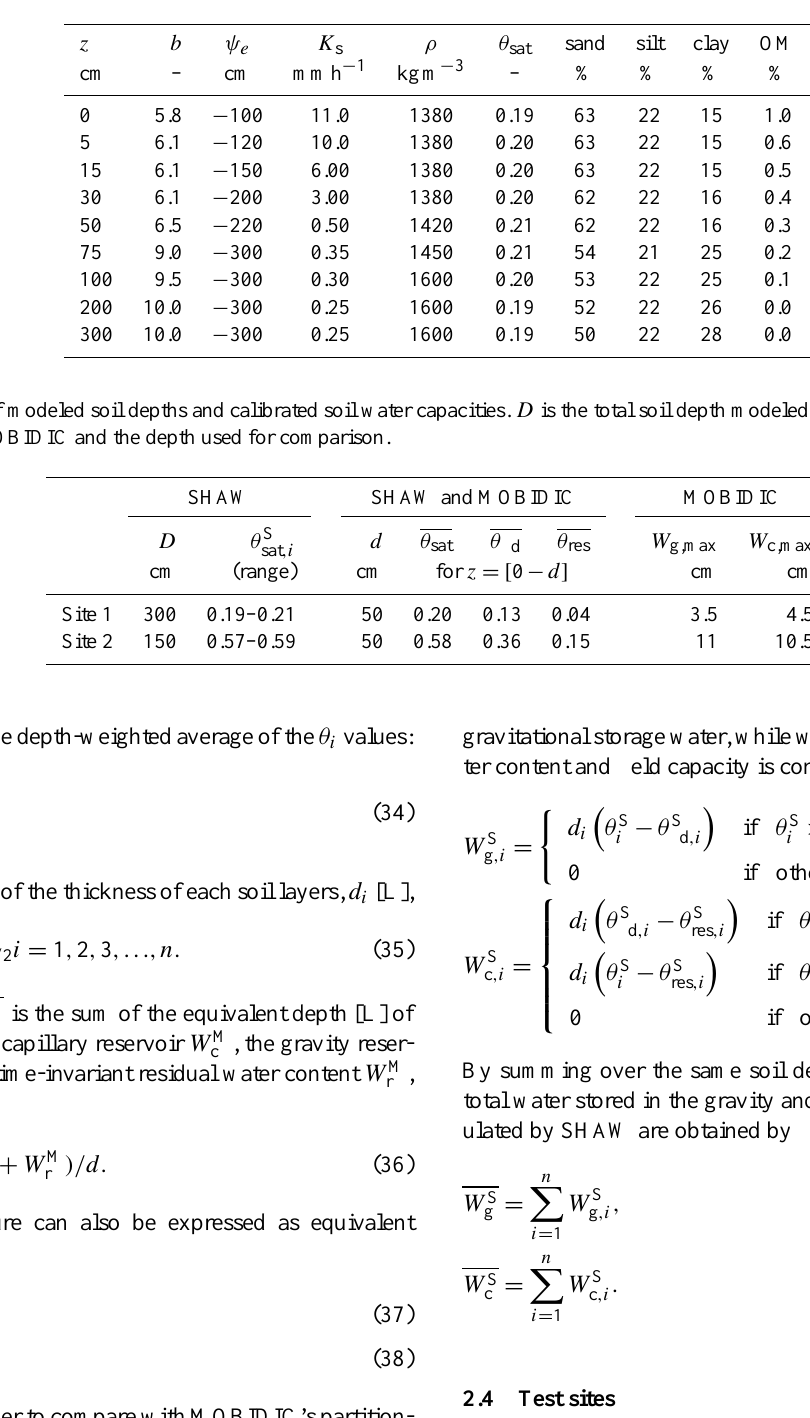
Table 2. Calibrated soil properties of the SHAW model of Site 1. b and ψ e are the Campbell pore-size distribution index and air-entry potential, respectively. z was fixed; percent sand, silt, and clay is based on observations, while the rest is manually calibrated but constrained by typical values reported by Rawls et al. (1982).